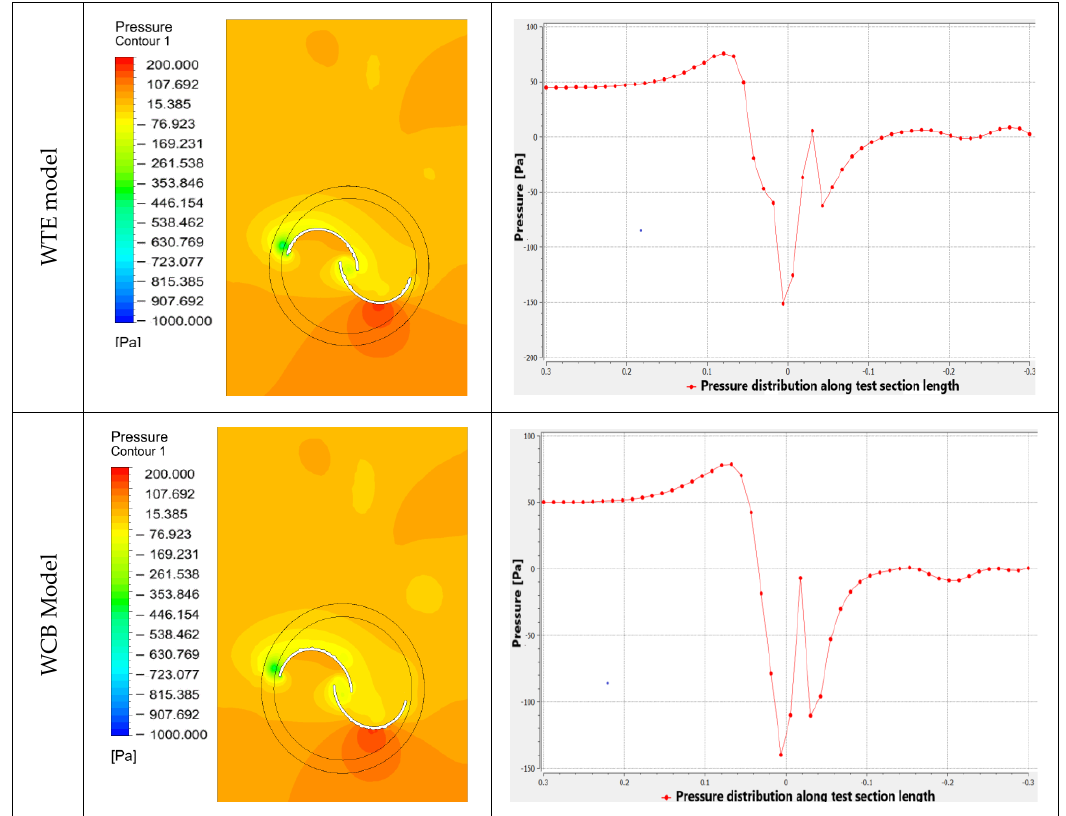
Figure 15. Pressure contours and diagrams for pressure distribution along test section at TSR 1.